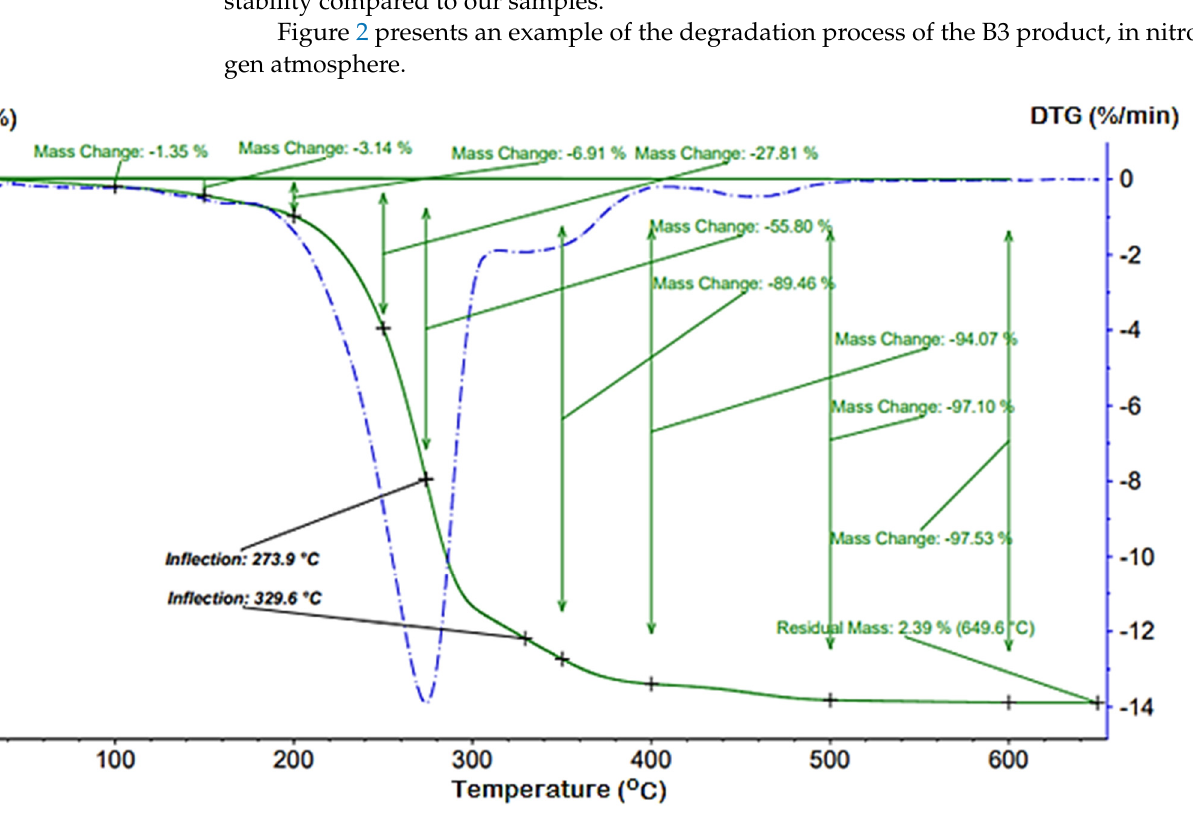
Figure 2. TG/DTG curves of bioester B3, in nitrogen atmosphere.